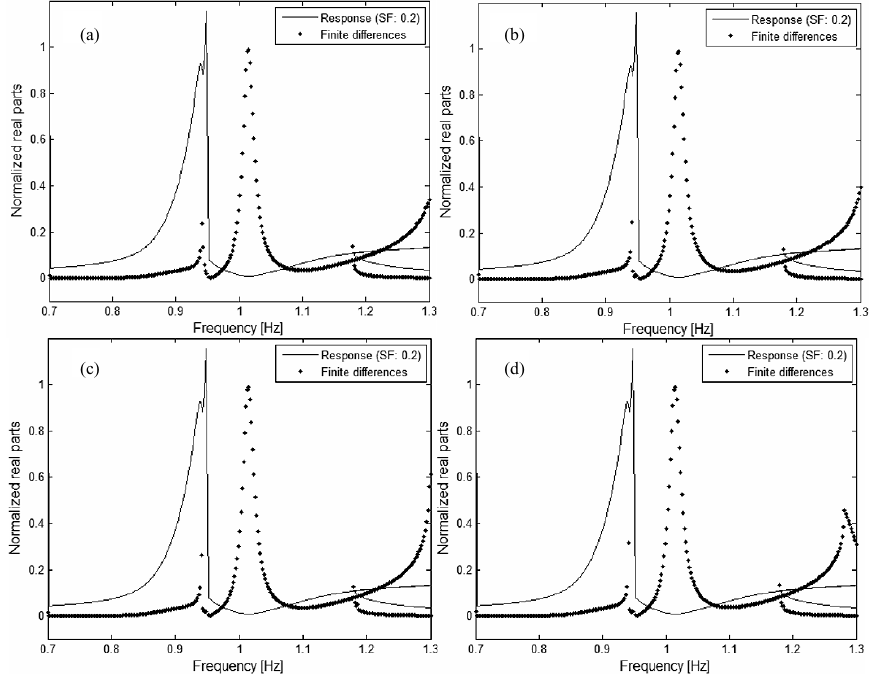
Fig. 5. Finite difference estimations of the Response H ( ω,p ) with respect to ξ 2 : (a) ∆ ξ 2 / ξ 2 = 1%; (b) ∆ ξ 2 / ξ 2 = 5%; (c) ∆ ξ 2 / ξ 2 = 10%; (d) ∆ ξ 2 / ξ 2 =